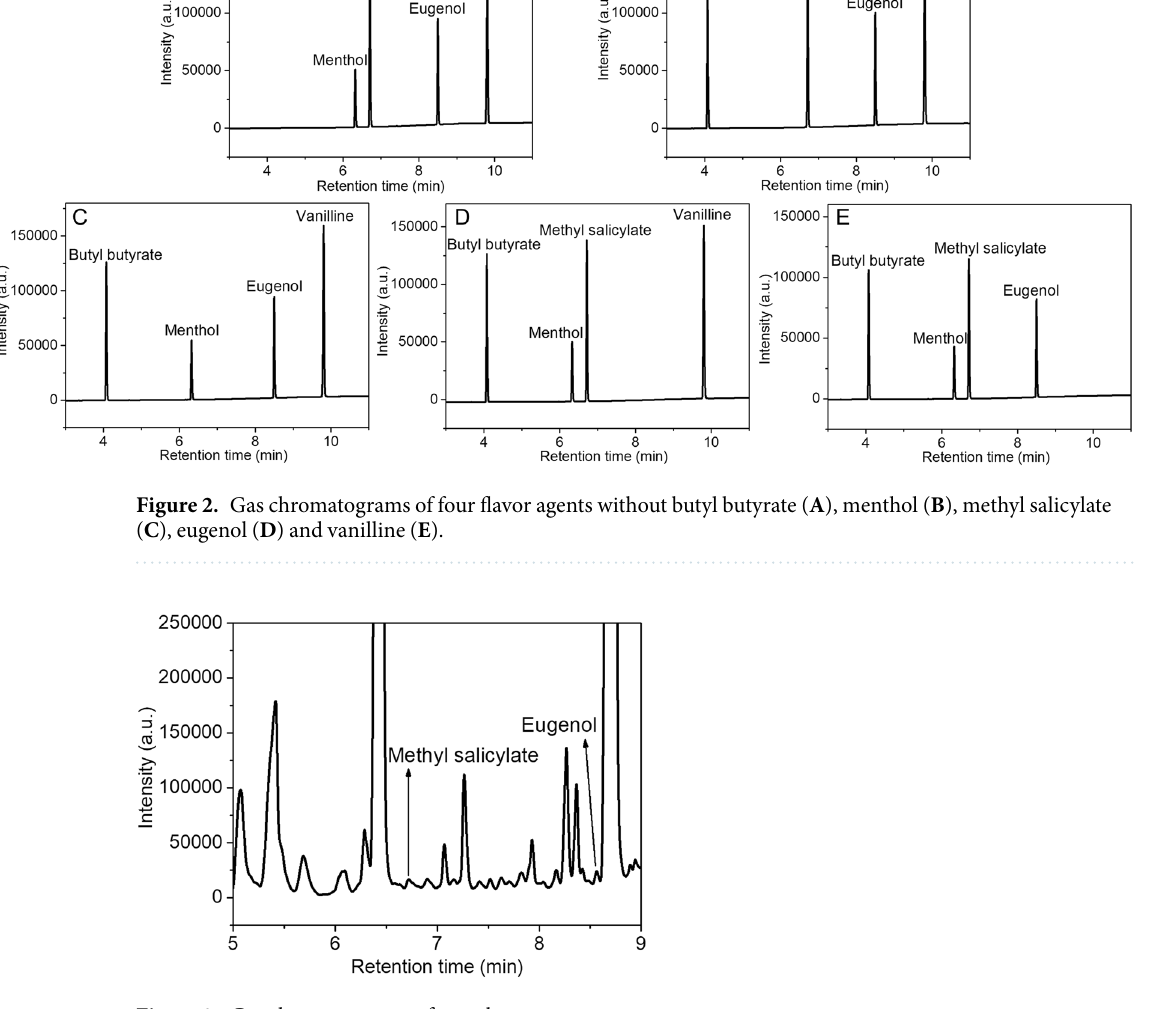
Figure 3. Gas chromatograms of strawberry-gum